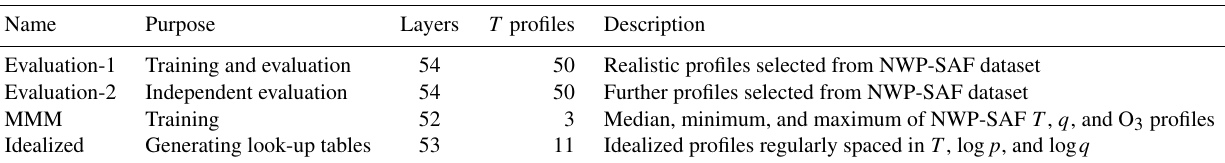
Table 3. The four spectral optical depth datasets generated as part of CKDMIP, where T is temperature, p is pressure, and q is specific humidity.